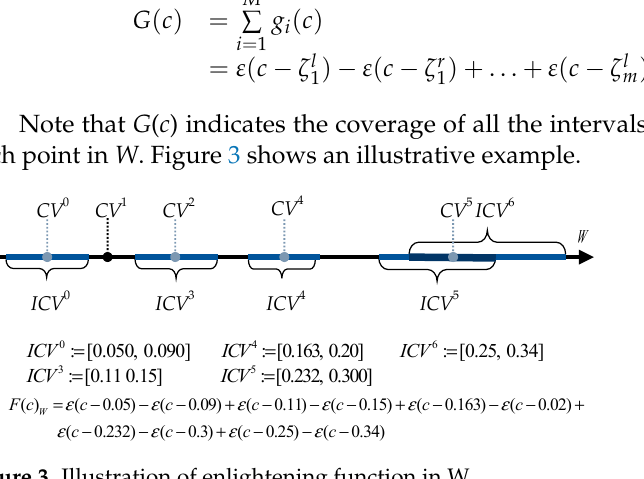
Figure 3. Illustration of enlightening function in W.